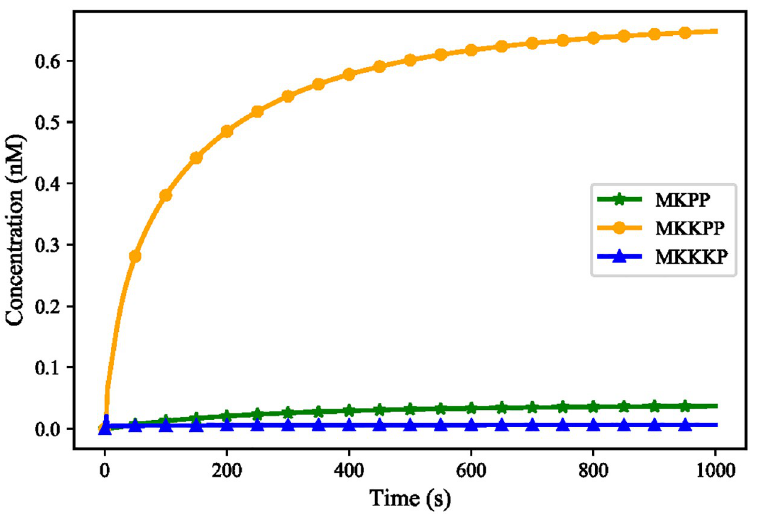
Fig 16. Time course behaviour of the terminal kinases in the composed EGFR-Ras-MAPK bond graph model with negative feedback.